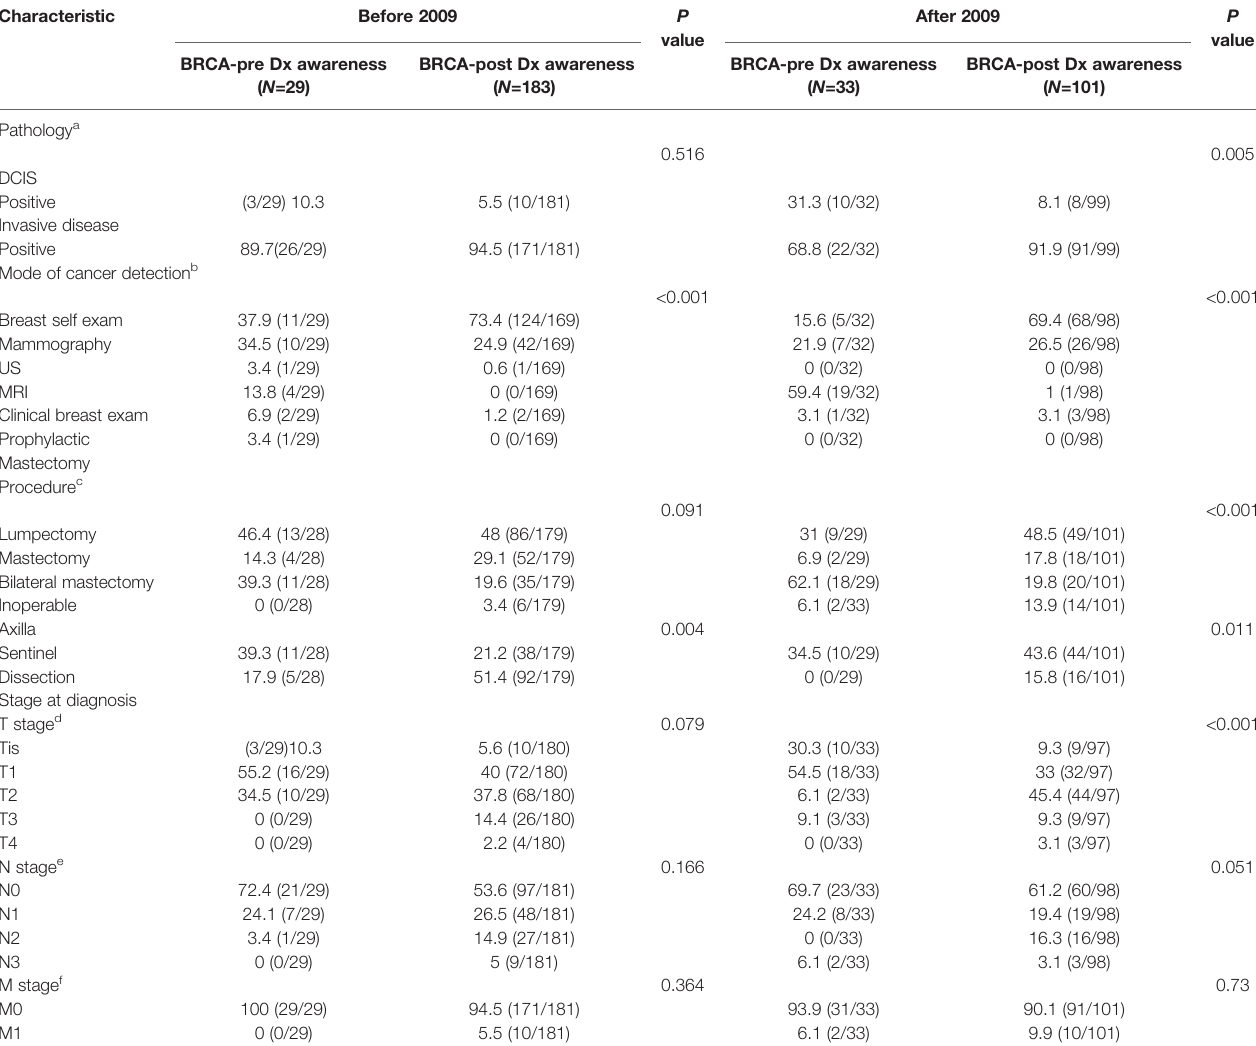
TABLE 4 | Outcomes following inclusion of MRI in the national health services.